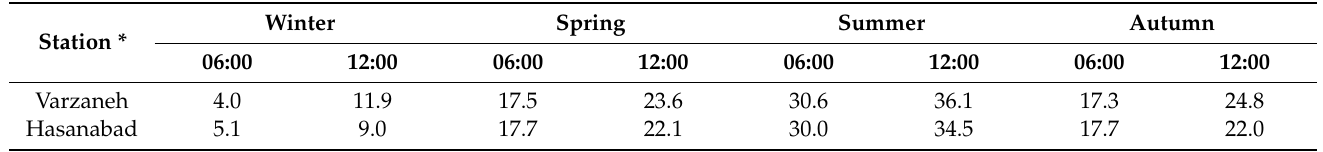
Table 2. Long-term seasonal ** average of observed air temperature (Tair_obs_m) in two available stations at 06:00 and 12:00